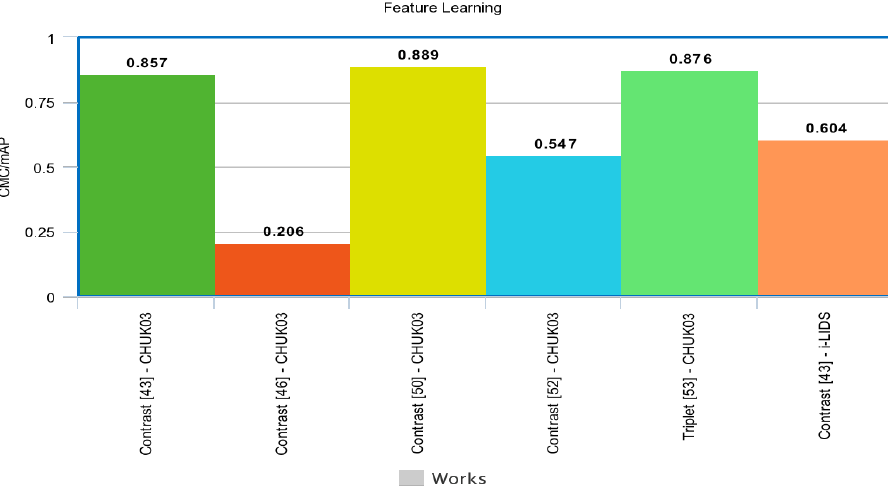
Figure 6. Performance summary of the evaluated deep learning metric